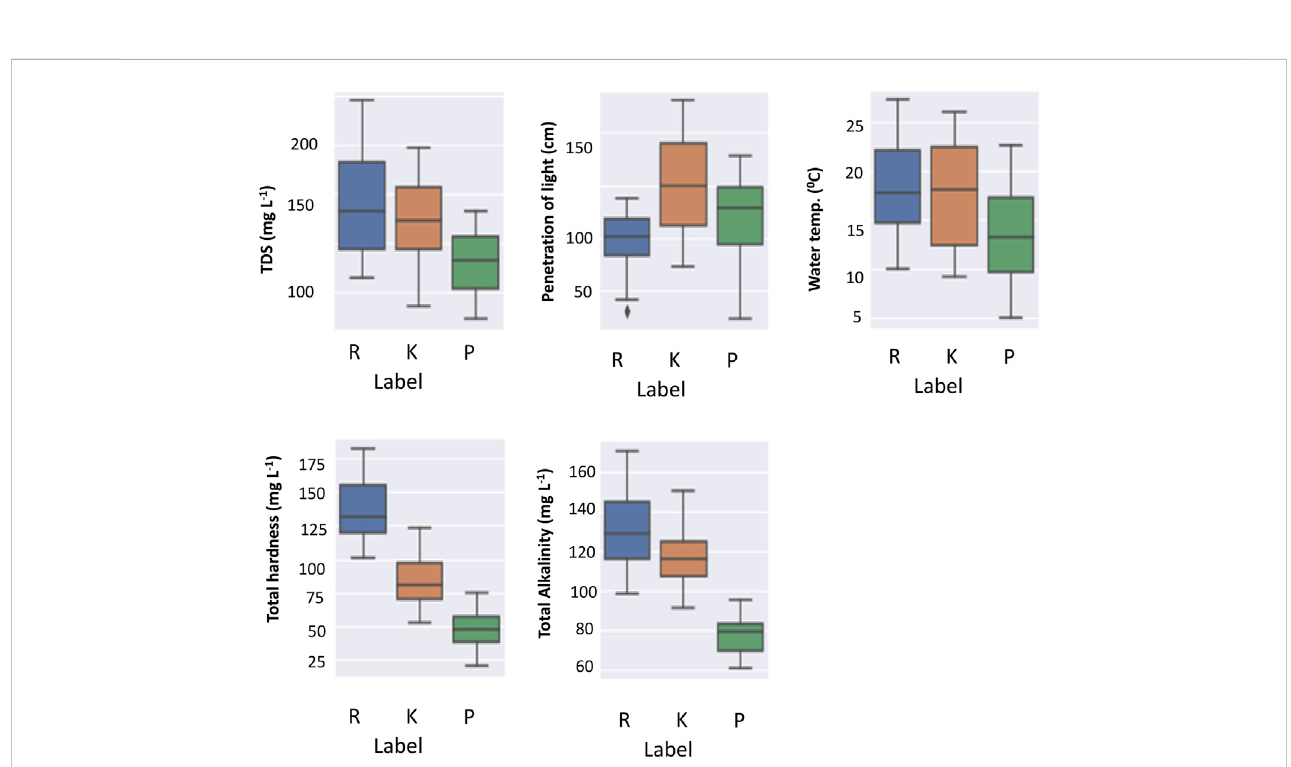
FIGURE 6 Top fi ve parameters that contributed the information entropy were analyzed for the spread. Rewalsar (R-Blue), Kuntbhyog (K-Orange), and Prashar (P-green) lakes. The spread of the values of the three lakes is shown.